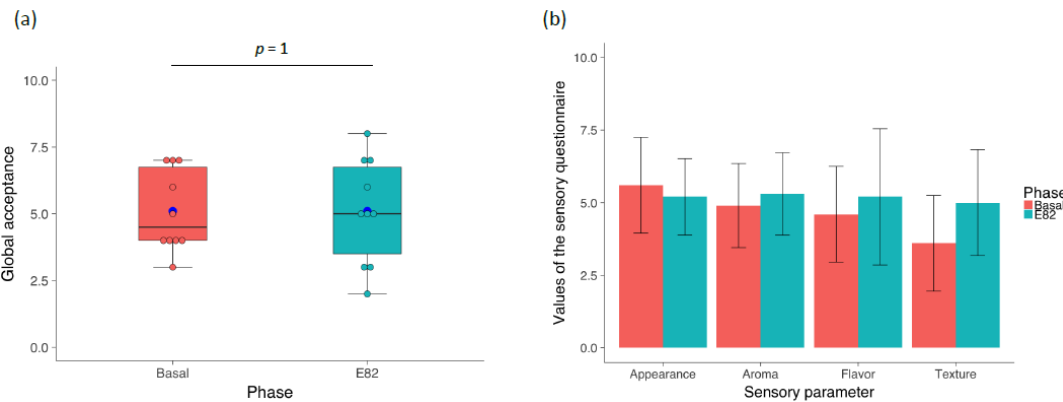
Figure 3. ( a ) Differences in global acceptance of the two phases of the dietary intervention; ( b ) Values of the sensory questionnaire for appearance, aroma, flavor, and texture for the gluten-free bread (Basal) and the low-gliadin bread (E82).